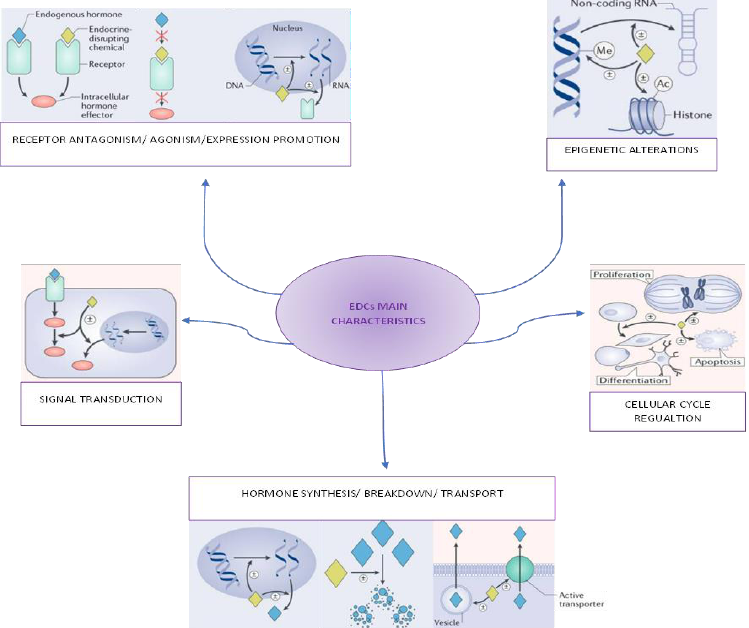
Figure 1. Main characteristics of EDCs. Adapted by Michele A La Merill et al., Nature Reviews 2020 [30]. The ± symbol indicates an EDC’s effect (increase/decrease processes).